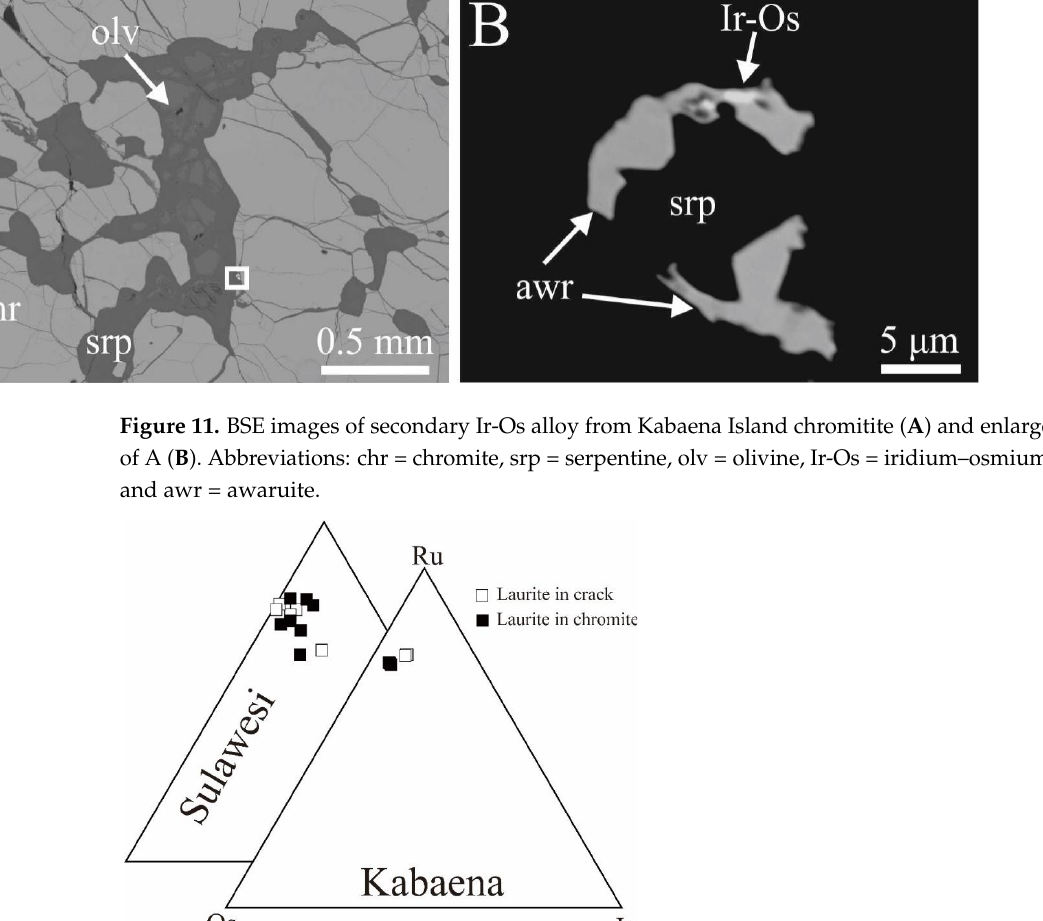
Figure 12. Plots (atom %) of the compositions of laurite from the chromitites of Kabaena (present work) and Sulawesi [38]. Table 4. Selected microprobe analyses of laurite (wt% and at%) from chromitites of the Kabaena Island